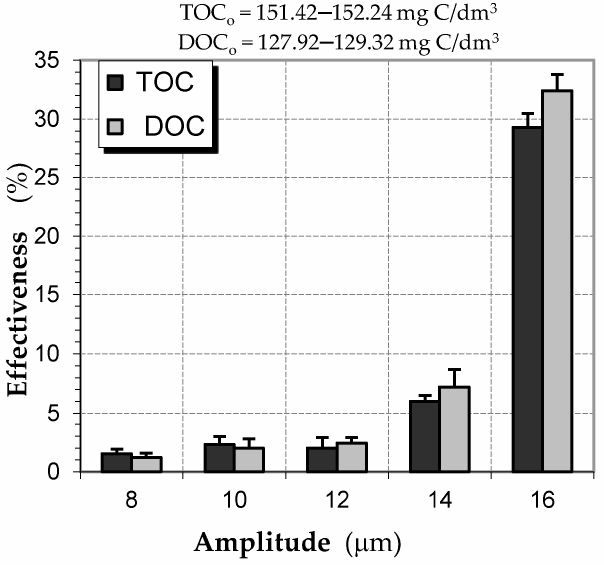
Figure 1. Effectiveness of decreasing the examined indices of organic contamination using the ul- trasonic field (t us = 5 min). ultrasonic field (t us = 5